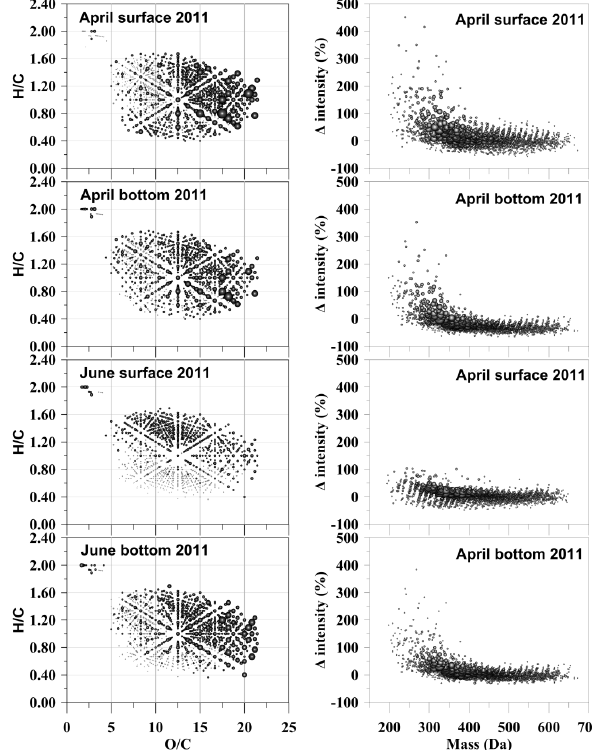
Fig. 7. Photochemically induced changes in the molecular composi- tion of a boreal lake SPE-DOM at the surface and bottom in spring (ice covered) and at the surface and bottom in summer shown in van Krevelen diagrams and the observed relative changes in intensity for all mass peaks, respectively. (Note: black bubbles represent molec- ular formulas with an increase in associated relative abundances of the mass peaks after 24h solar simulated irradiation and open bub- bles with a decrease,